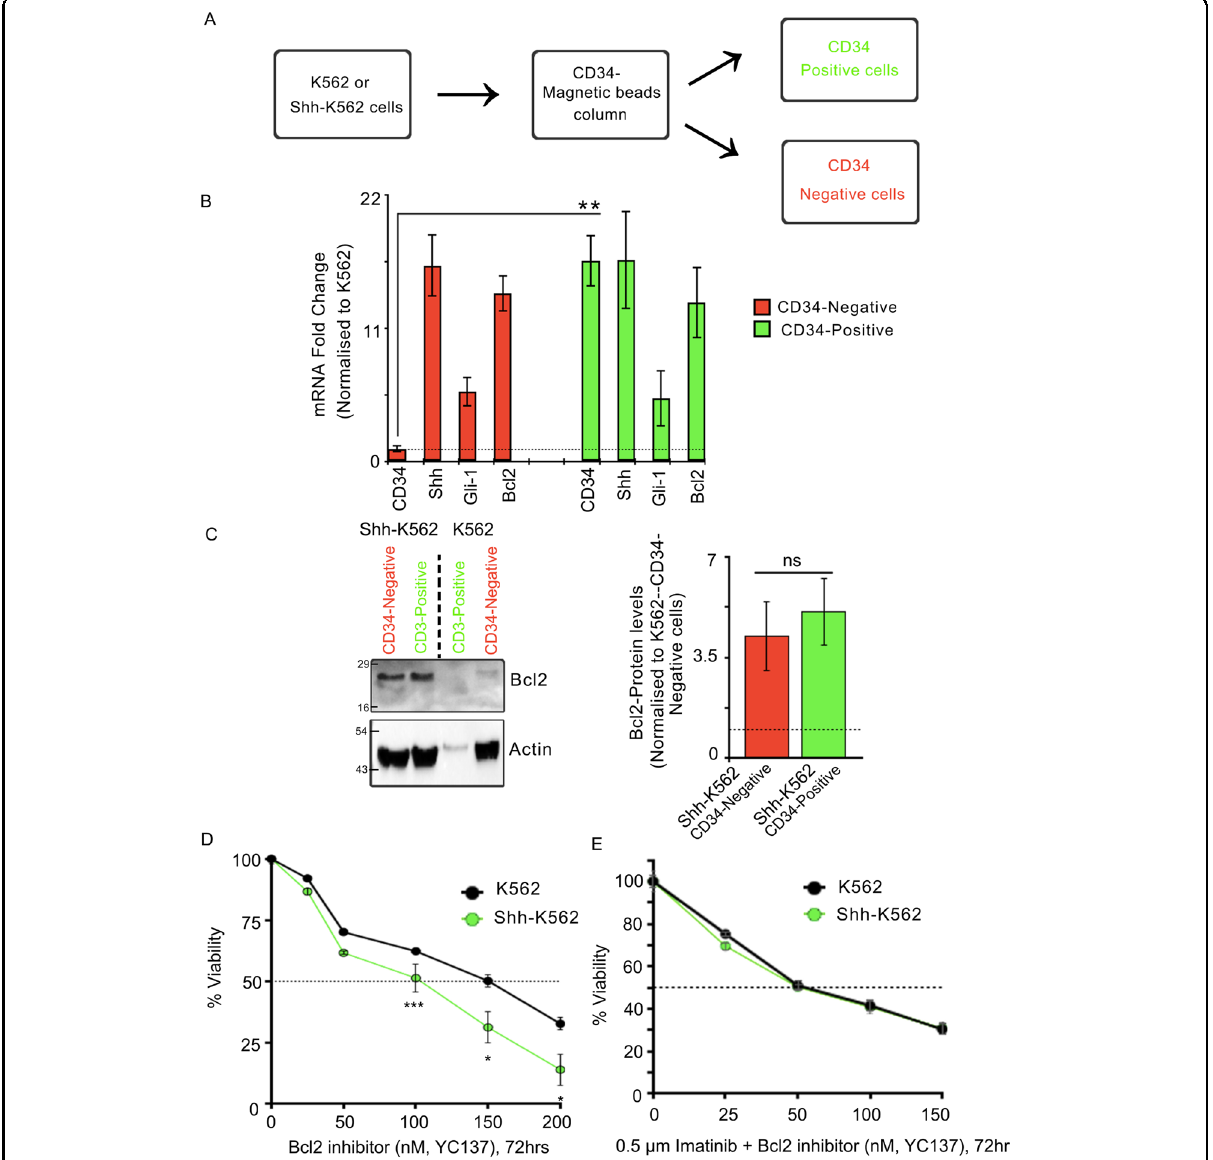
Fig. 5 Stemness and Bcl2 are independent targets of Shh signaling. A Flowchart representing method for obtaining CD34( + ) and CD34( – ) cells from K562 and Shh-K562 cell lines. B Graph depicts RT-PCR-based fold change in expression levels of CD34 , Shh , Gli-1 , and BCl2 in fractionated CD34 ( + ) (green bars) and negative cells (red bars). P values derived from two biological repeats. C Western blot representing Bcl2 protein levels in CD34 ( + ) and CD34( – ) Shh-K562 and K562 cells. Actin used as loading control. Graph represents densitometric analysis of relative Bcl2 levels in Shh-K562- CD34( + ) (red bar) and Shh-K562-CD34( – ) (green bar) cells using K562-CD34( – ) cells as normalizing control. Bar represents mean ± SD from two biological repeats. D Viability of Shh-K562 (in green) and K562 cells (in black; control) after treatment with different concentration of YC137 (Bcl2 inhibitor II) to identify IC50 at 72 h. Untreated cells at respective time-point used as reference. Line graph represents mean ± SD from three biological repeats. E Percentage viability of Shh-K562 (in green) and K562 cells (in black; control) after treatment with Imatinib (0.5 μ M) + different concentration of YC137 (Bcl2 inhibitor II) to identify lowest effective concentration. Untreated cells at respective time-point used as reference. Line graph represents mean ± SD from three different experiments. P values, *<0.05, **<0.01, and ***<0.001. Statistical analysis done using t